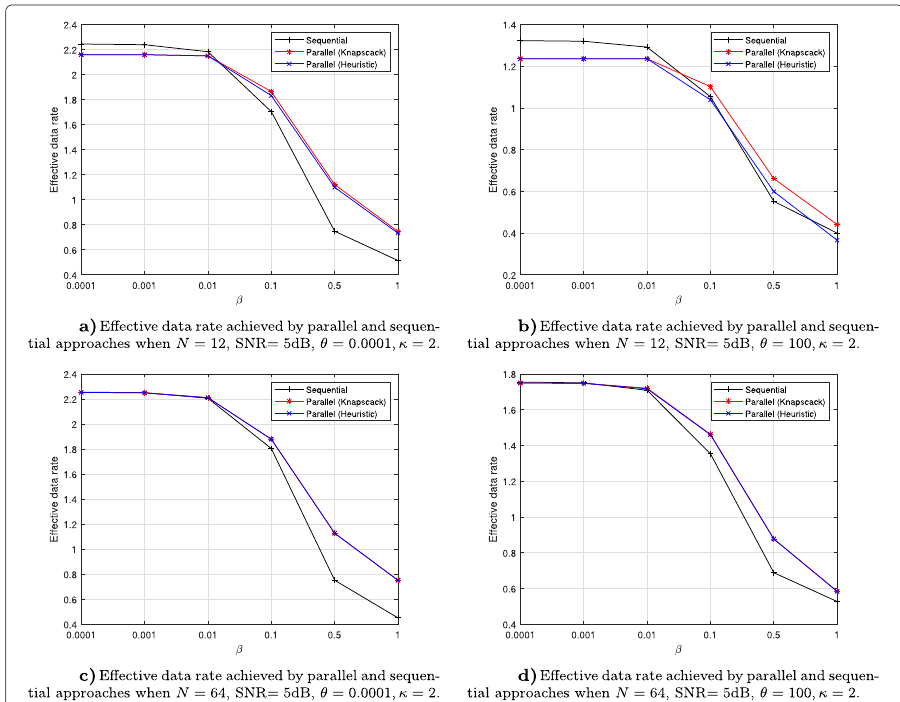
Fig. 8 a Effective data rate achieved by parallel and sequential approaches when N = 12, SNR = 5dB, θ = 0.0001, κ = 2. b Effective data rate achieved by parallel and sequential approaches when N = 12, SNR = 5dB, θ = 100, κ = 2. c Effective data rate achieved by parallel and sequential approaches when N = 64, SNR = 5dB, θ = 0.0001, κ = 2. d Effective data rate achieved by parallel and sequential approaches when N = 64, SNR = 5dB, θ = 100, κ = 2